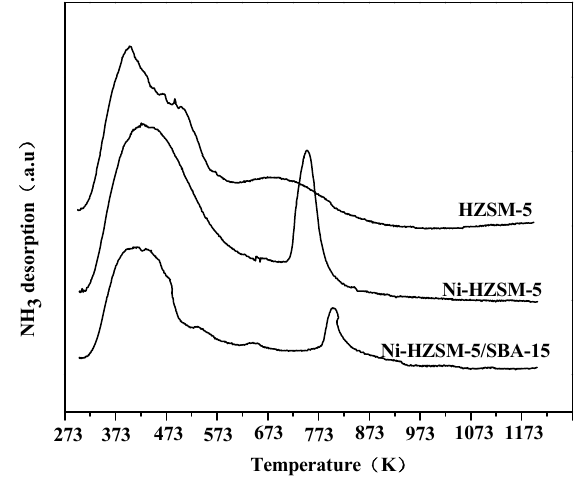
Figure 4. NH 3 -TPD analysis of different nickel catalysts.